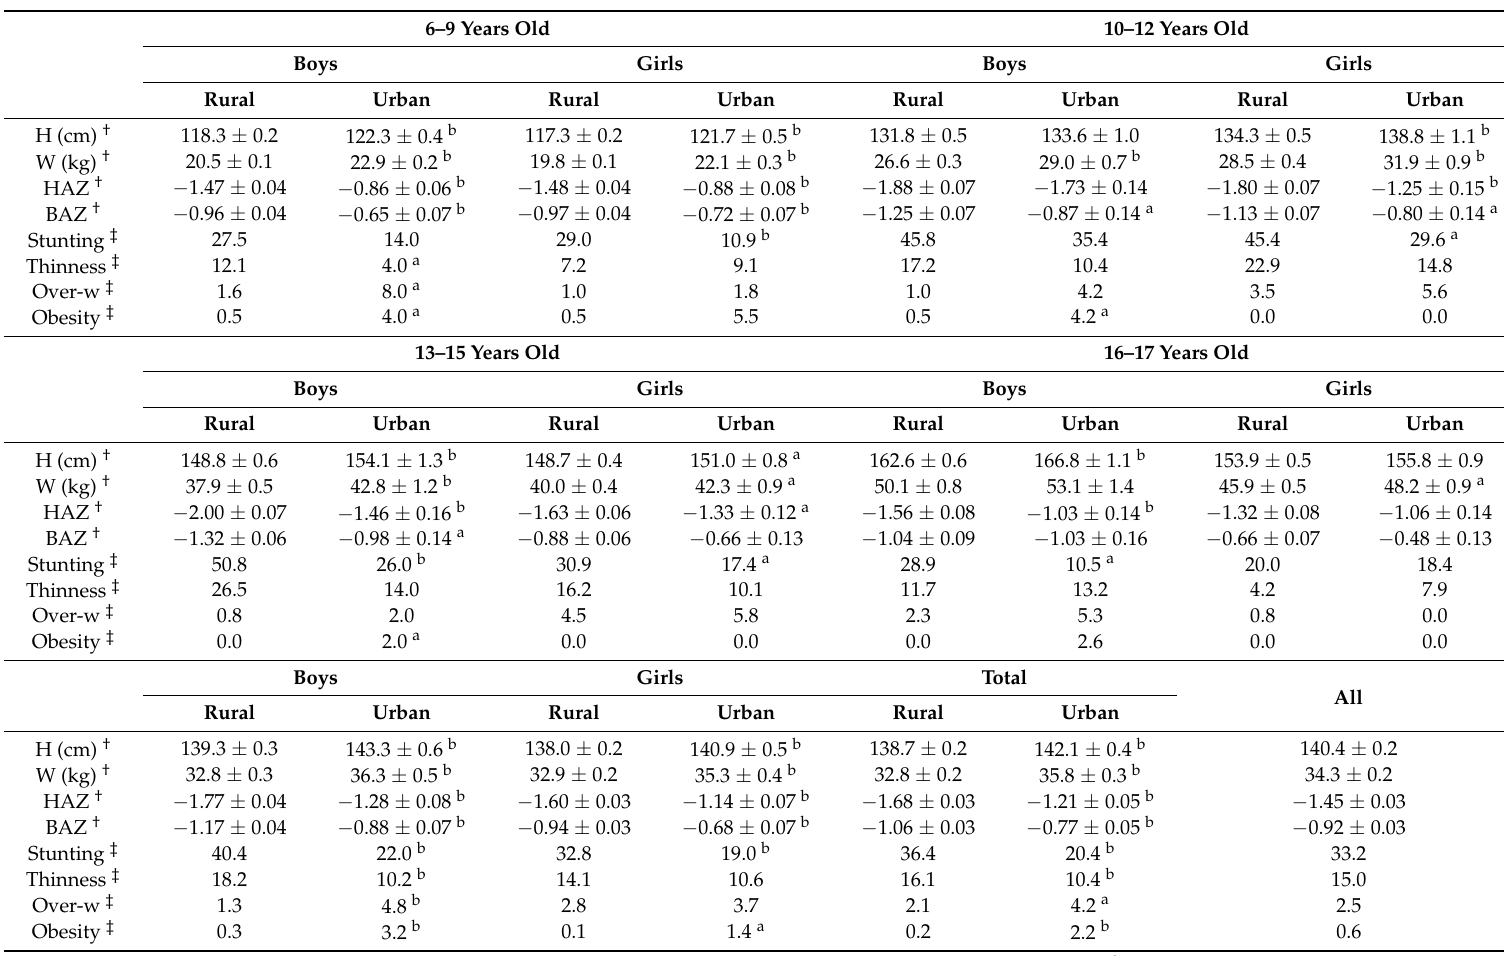
Table 2. Anthropometric characteristics (mean values ± standard errors) † and prevalence (%) ‡ of under and overnutrition by age group and area of